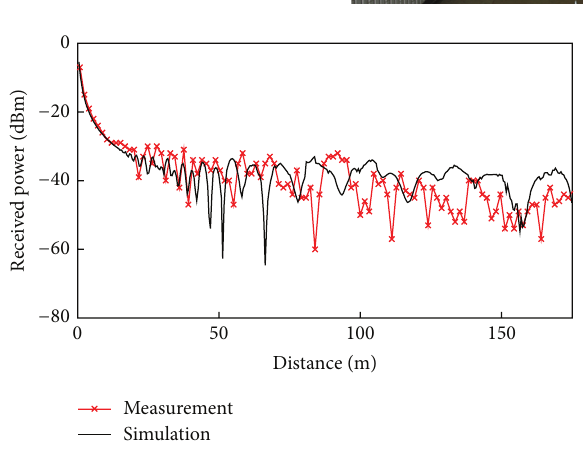
Figure 6: Received power levels in the second test